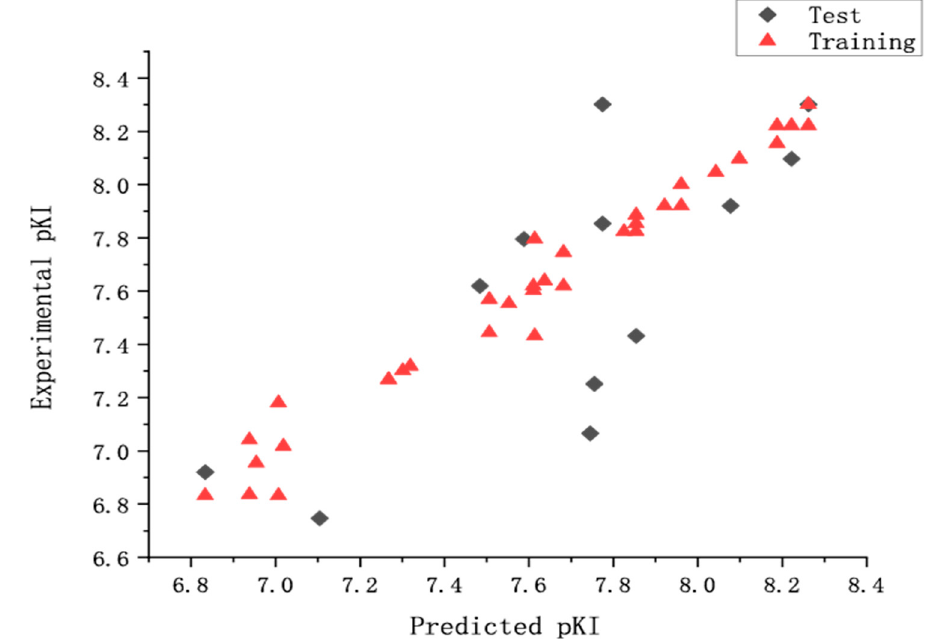
Figure 2. The predicted and the experimental pKi values (nM) of CoMSIA model. Table 1. Structures of the azinesulfonamides of cyclic amine derivatives and Ki values.